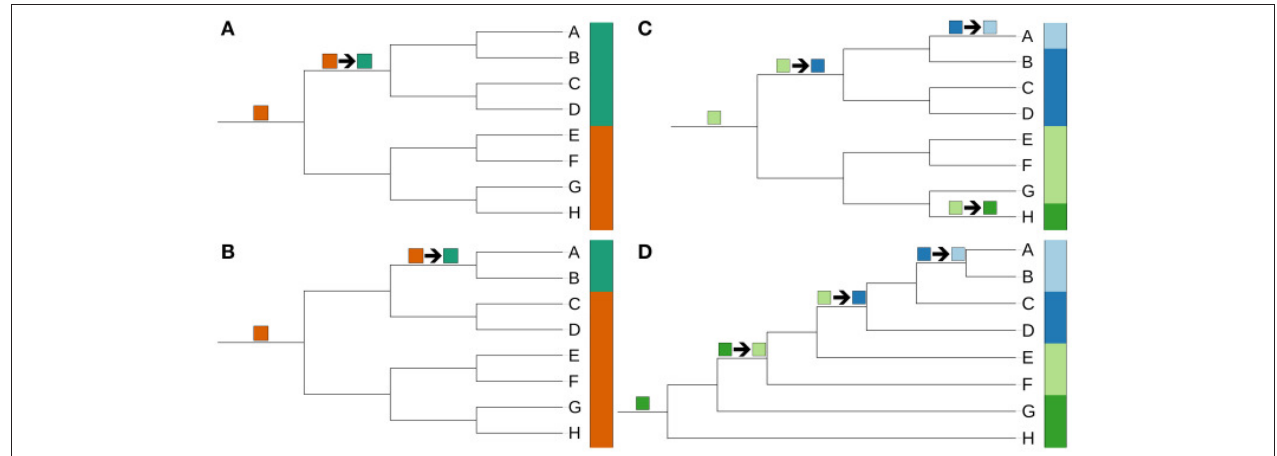
FIGURE 10 | Hypothetical trees and character-state distributions illustrating the impossibility to detect “diagnostic” character states for monophyletic groups even in the case of a perfect fit of the character to the phylogeny. Most-parsimonious reconstructions of changes between character states are indicated by arrows. (A) Maximally symmetric tree with eight tips and a binary character without homoplasies. Each of the two character states is diagnostic for a clade. The orange-red state is actually plesiomorphic but accidentally happens to occur in a single clade only. (B) Same tree as before together with another binary character without homoplasies. Only one of the two character states is diagnostic for a monophyletic group. The orange-red state is again plesiomorphic, hence it comes as no surprise that it characterizes a paraphyletic group. (C) Same tree as before in conjunction with a multi-state character without homoplasies. Only two of the four states, light blue and dark green, are diagnostic, each for a distinct clade. (C) Maximally asymmetric tree with eight tips in conjunction with another multi-state character without homoplasies. Only one of the four states, light blue, is diagnostic for a